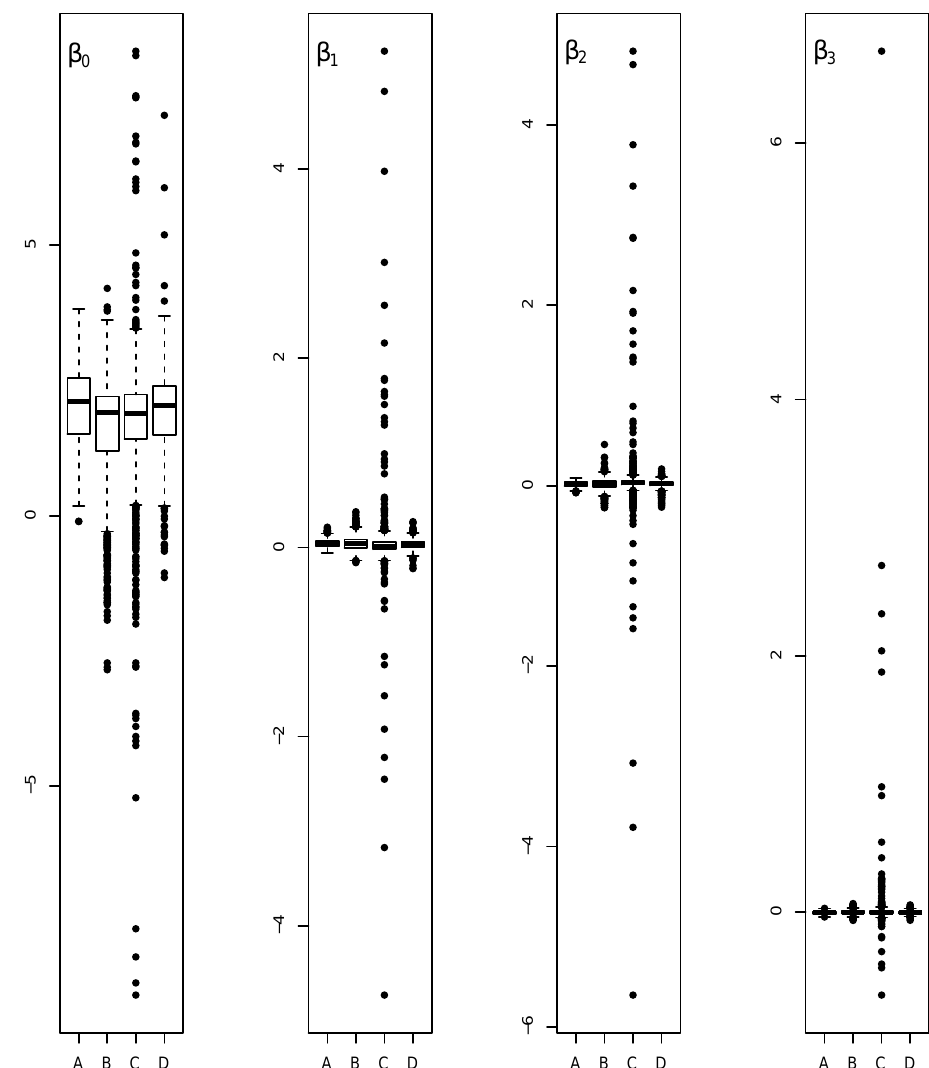
Figure 7. Boxplots of the coefficient estimates ˆ β 0 , ˆ β 1 , ˆ β 2 , and ˆ β 3 of the NB model for length of stays ( n = 50); A = ML, B = MD10r, C = MCML10, D = MCML +